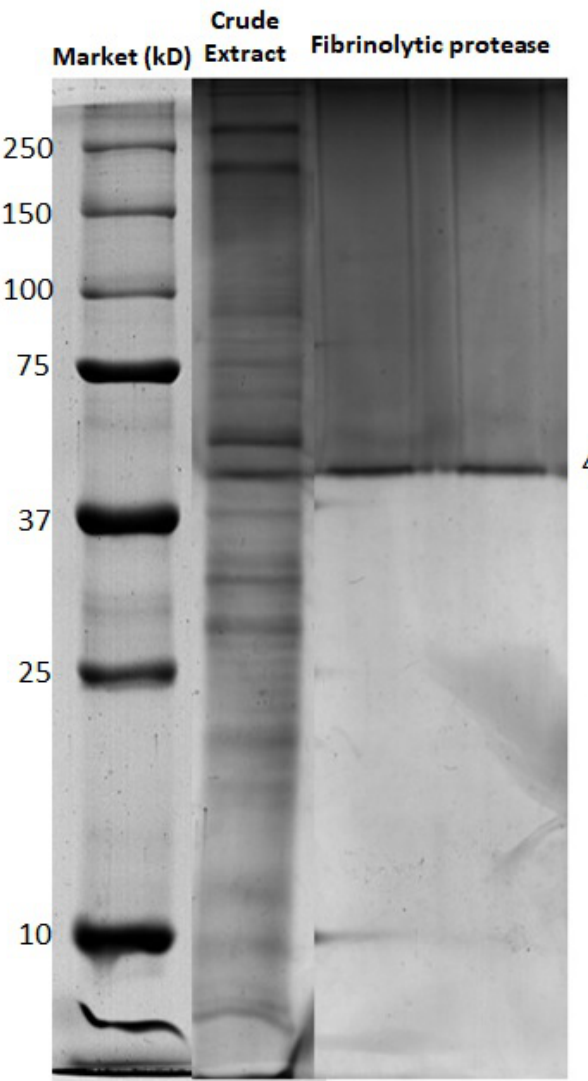
Figure 5. Molecular mass determination of the fibrinolytic protease by SDS-PAGE (12%) with protein molecular mass marker (Precision Plus Protein Dual Color Standards). Quantity of the fibrinolytic protease (µg): Crude Extract and fibrinolytic protease (5 µg lyophilized fibrinolytic enzyme).